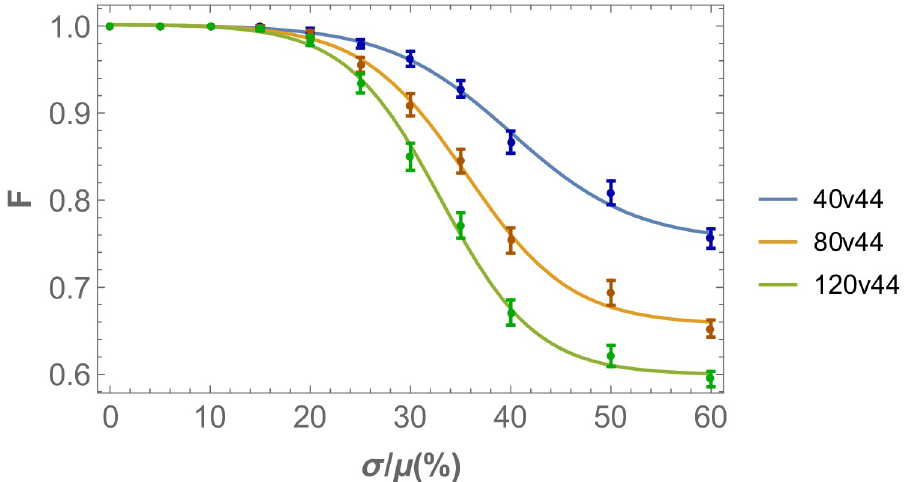
Fig 13. Pattern order as a function of eye disc size (same parameter sets as in Fig 8). The threshold response is more pronounced as the length of the eye disc in the direction of the morphogenetic furrow is increased. The order parameter is calculated for cell number 40, 80 and 120 while keeping the size perpendicular to the propagation direction of the morphogenetic furrow at 44 cells. The order measure used is the fidelity of the nearest neighbor distance probability distributions and noise is added on the diffusivity of the